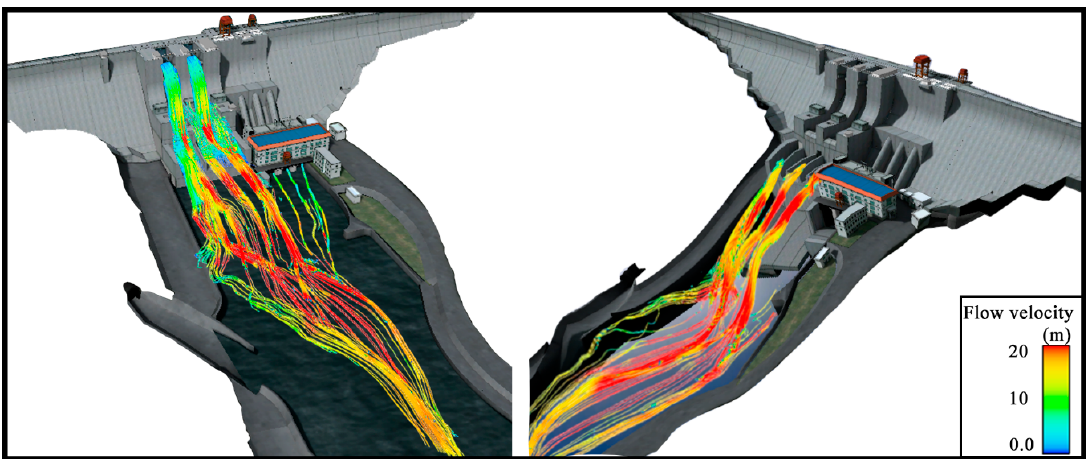
= 28 s with / without spillway discharge.